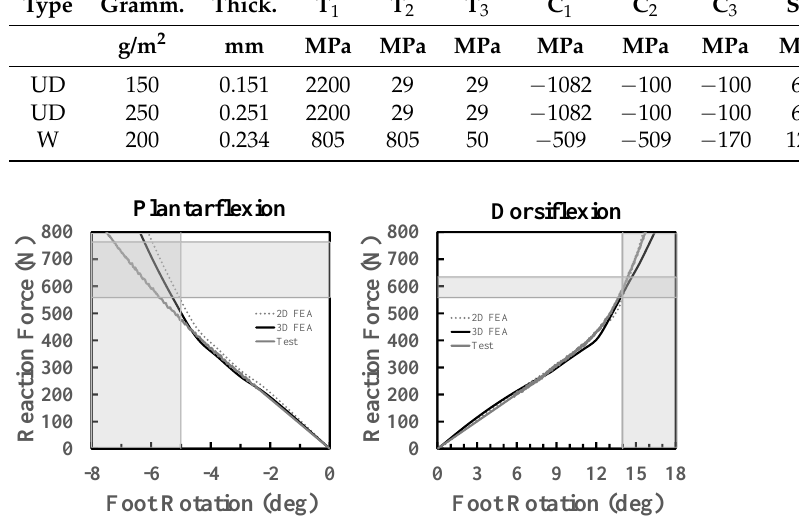
Figure 24. Comparisons among the static plantarflexion and dorsiflexion 2D FEAs and 3D FEAs and the mechanical tests on the physical prototype with stiffness curves givens as reaction force– rotation . Again, the vertical shadow is the rotation range that the foot must have (values defined and specified in Section 2.4, “Biomechanical Requirements”, i.e., between − 5 degrees and − 8 degrees in the plantarflexion and between 14 degrees and 18 degrees in the dorsiflexion). The horizontal shadow is the range of the ground reaction force (between 95% and 130% in plantarflexion and between 95% and 108% in dorsiflexion of the body weight of the user). The intersection area between the two shadows is the optimal area in which the curve of stiffness of the foot must fall, so that the foot rotates up to the degrees desired when subjected to ground reaction forces.